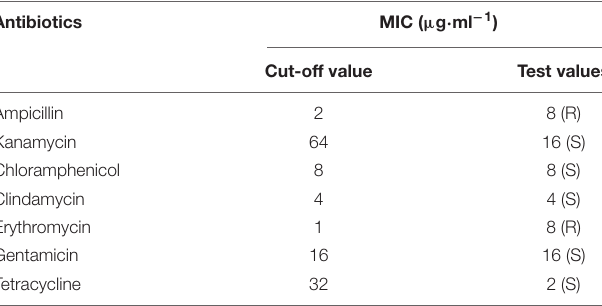
TABLE 2 | Minimum inhibitory concentration (MIC) of L. plantarum